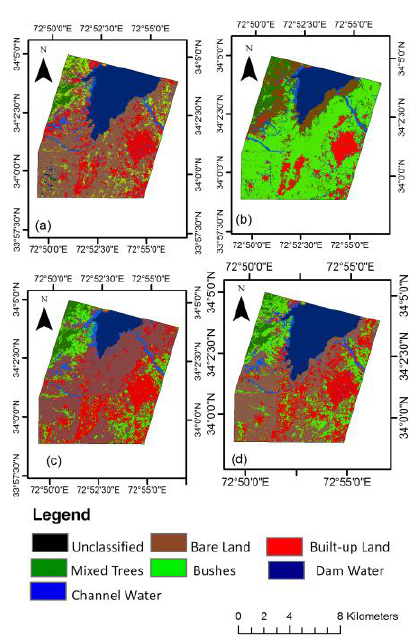
Figure 1. OLI SVM classified data (a) winter (23 November, 2015), (b) spring (27 February, 2016) (c) summer (2 June, 2016), and (d) autumn (24 October, 2016)